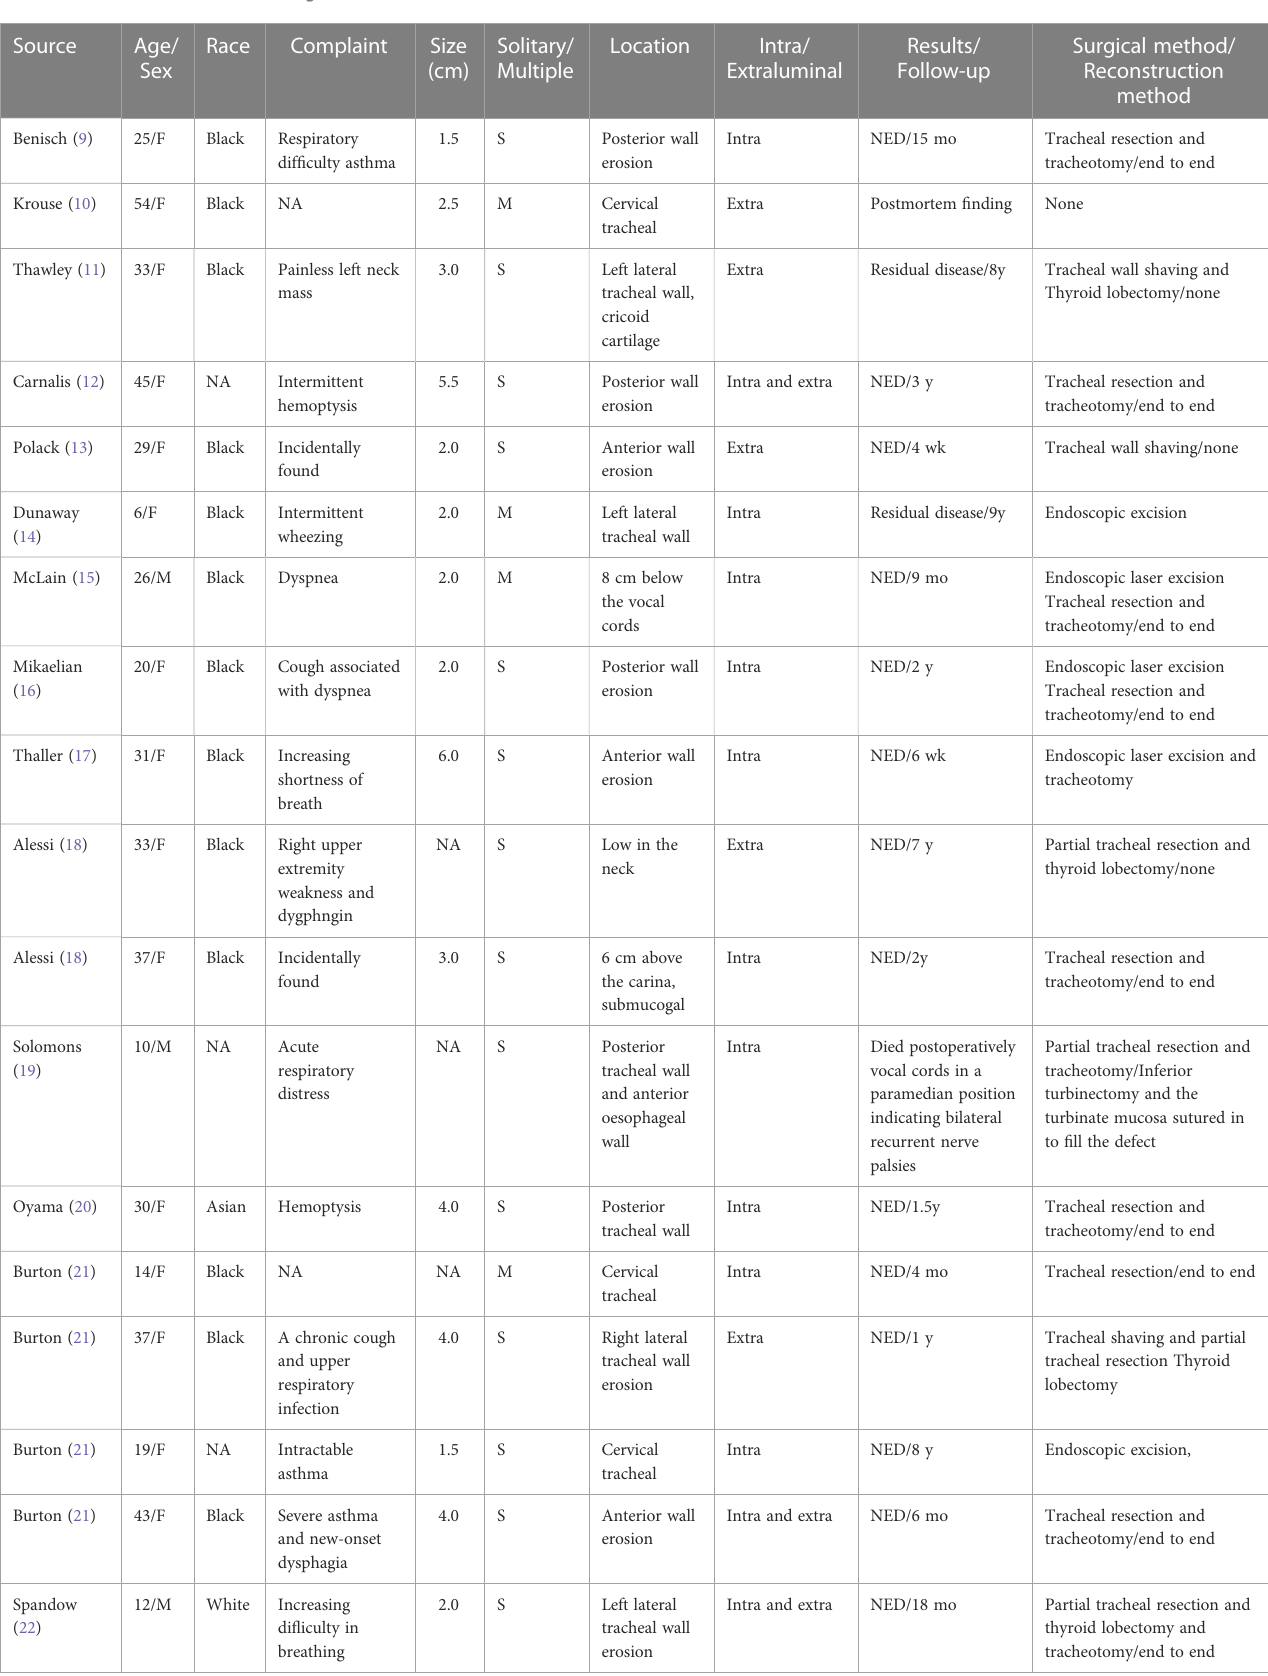
TABLE 1 Published data on tracheal granular cell tumors.